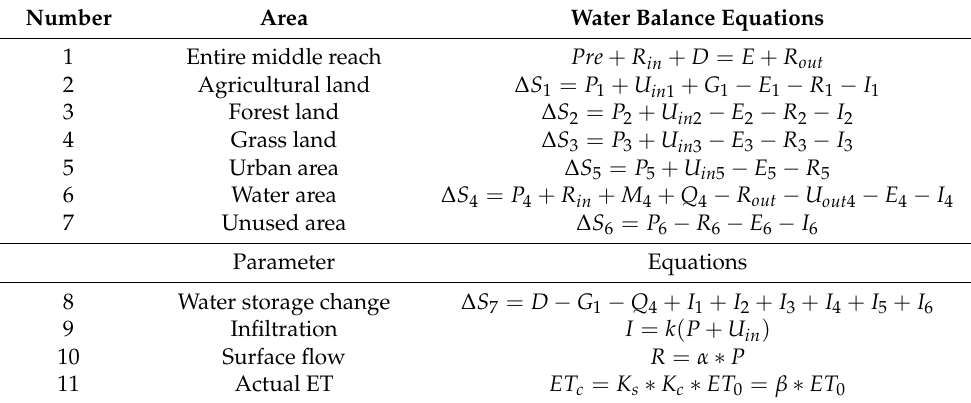
Table 3. Equations of the concept water balance model for the middle reach.